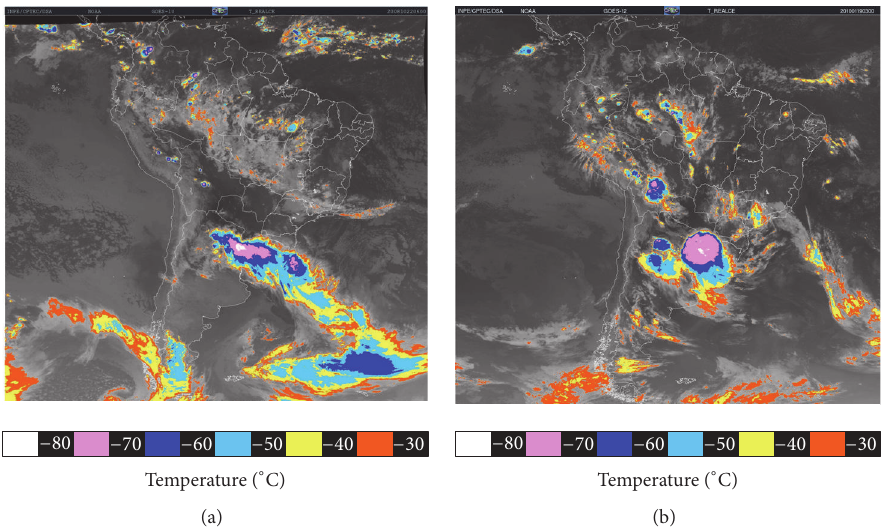
Figure2:EnhancedthermalinfraredimageryfromtheGeostationaryOperationalEnvironmentalSatellite(GOES)duringthematurestageof the MCSs: (a) GOES-10 at 0600 UTC 22 October 2008; (b) GOES-12 at 0300 UTC 19 January 2010. Colored shading scale indicates brightness temperatures in Celsius (source: National Oceanic and Atmospheric Administration (NOAA, USA) and Environmental Satellite Division of the National Institute for Space Research (DSA-INPE, Brazil)).